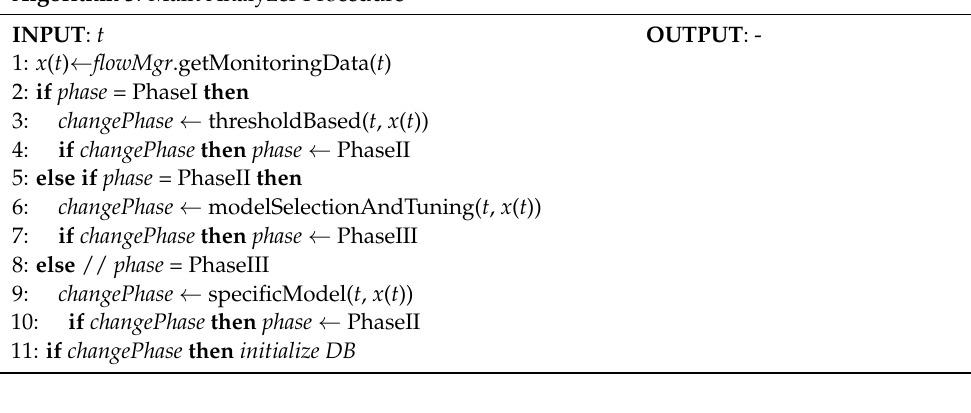
Algorithm 3 . Main Analyzer Procedure